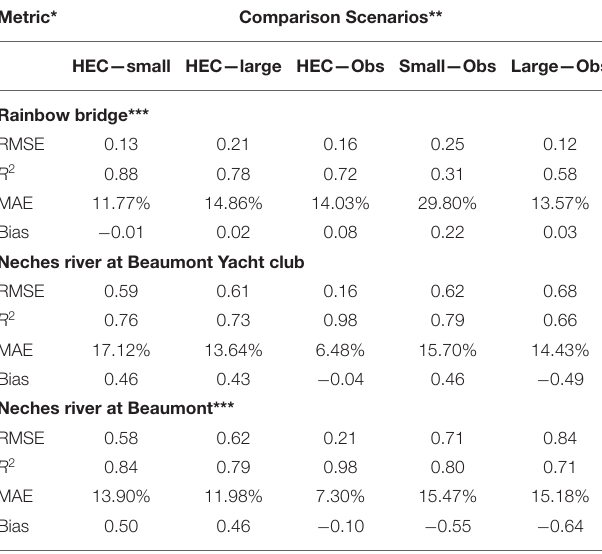
TABLE 1 | Evaluation metrics for different simulation scenarios. Metric* Comparison Scenarios**